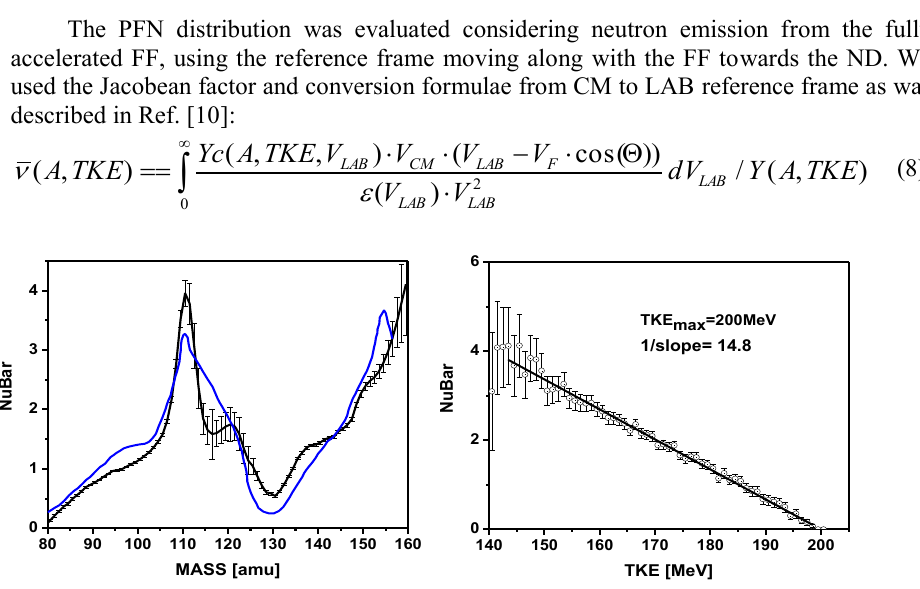
Fig. 3. The average PFN emission distribution mass dependence (black line), measured in 235 U(n th ,f) reaction in comparison with data (blue line) from Ref. [7] (on the left). The average PFN emission distribution dependence on FF TKE, measured in 235 U(n th ,f) reaction with TKE max = ~200 MeV (on the